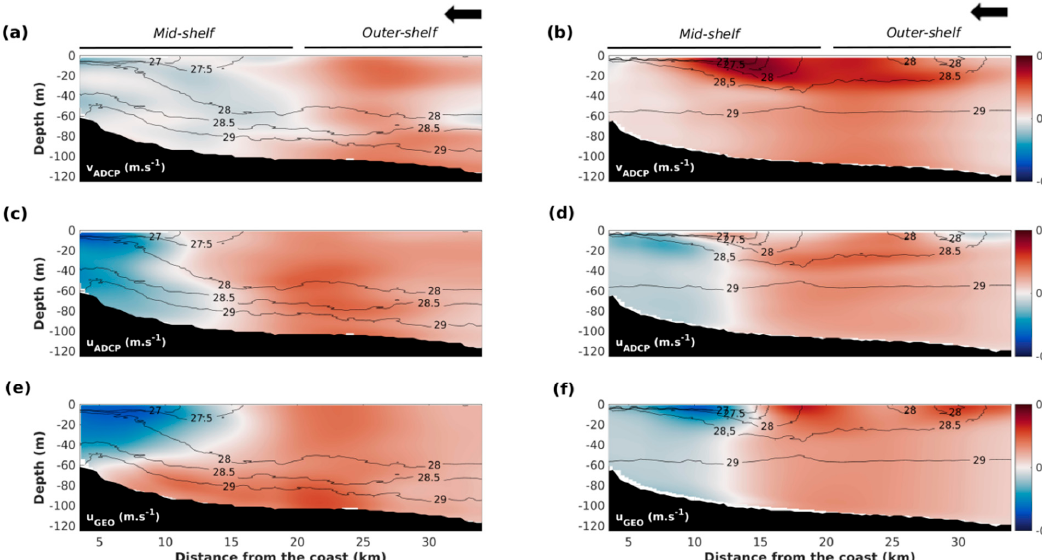
Figure 8. Hydrodynamical variables: ( a , b ) northward velocity, ( c , d ) eastward velocity, ( e , f ) and eastward geostrophic velocity. The left panels correspond to the autumnal season, from 11–13 November 2016. The right panels correspond to the winter season, from 5–7 February 2017. The black arrow at the top of each panel indicates the direction of the glider’s motion.